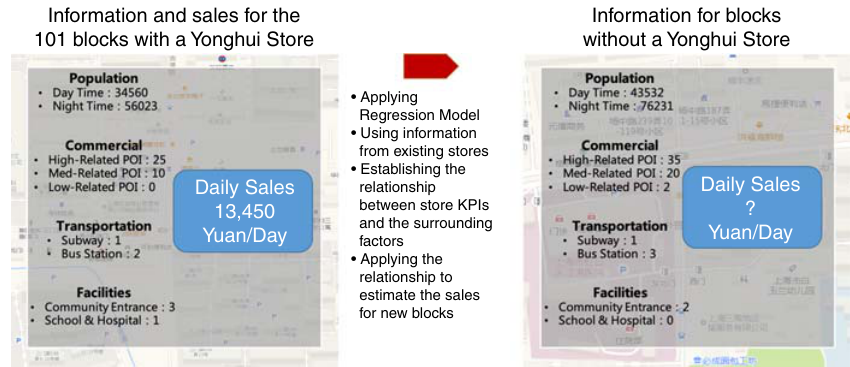
estimate the sales for new blocks